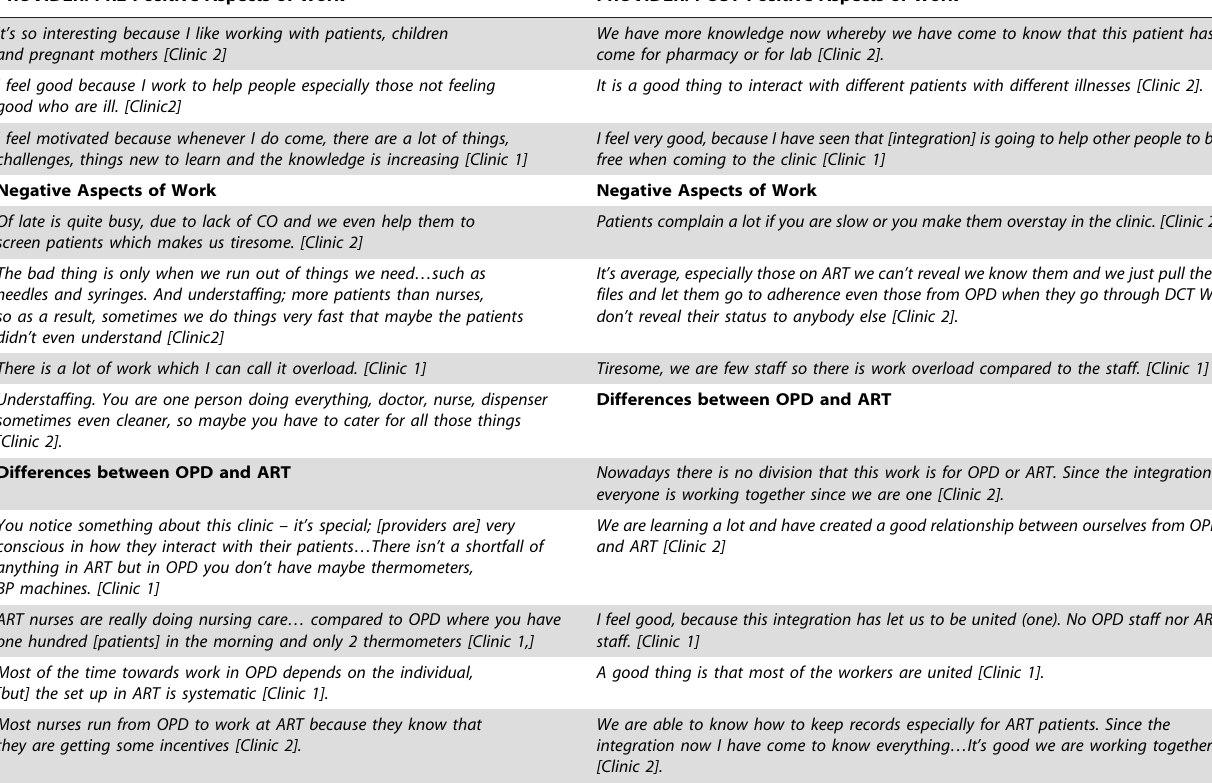
Table 2. Pre- and post-implementation provider